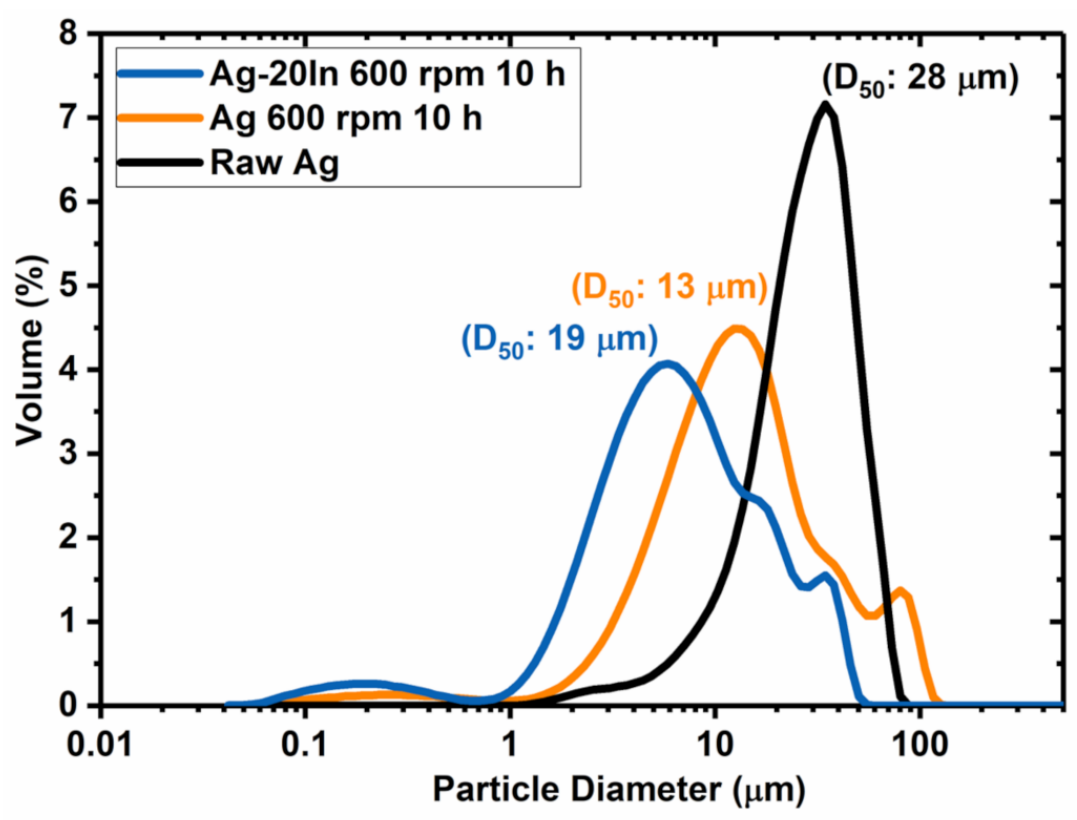
Figure 7. Particle size distributions for the Ag and Ag–In alloy powders after the ball-milling